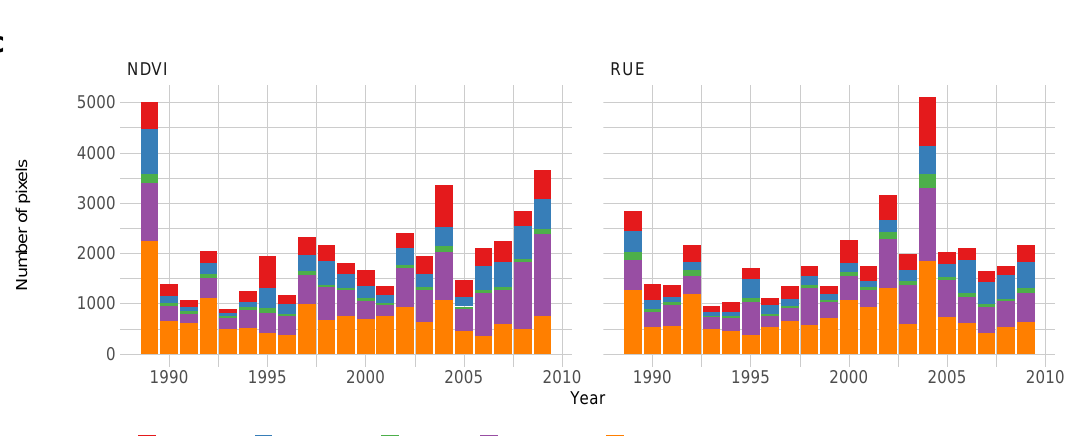
Figure 3. Trend breaks stratified by land cover: ( a ) trend type; ( b ) trend significance; ( c ) year of